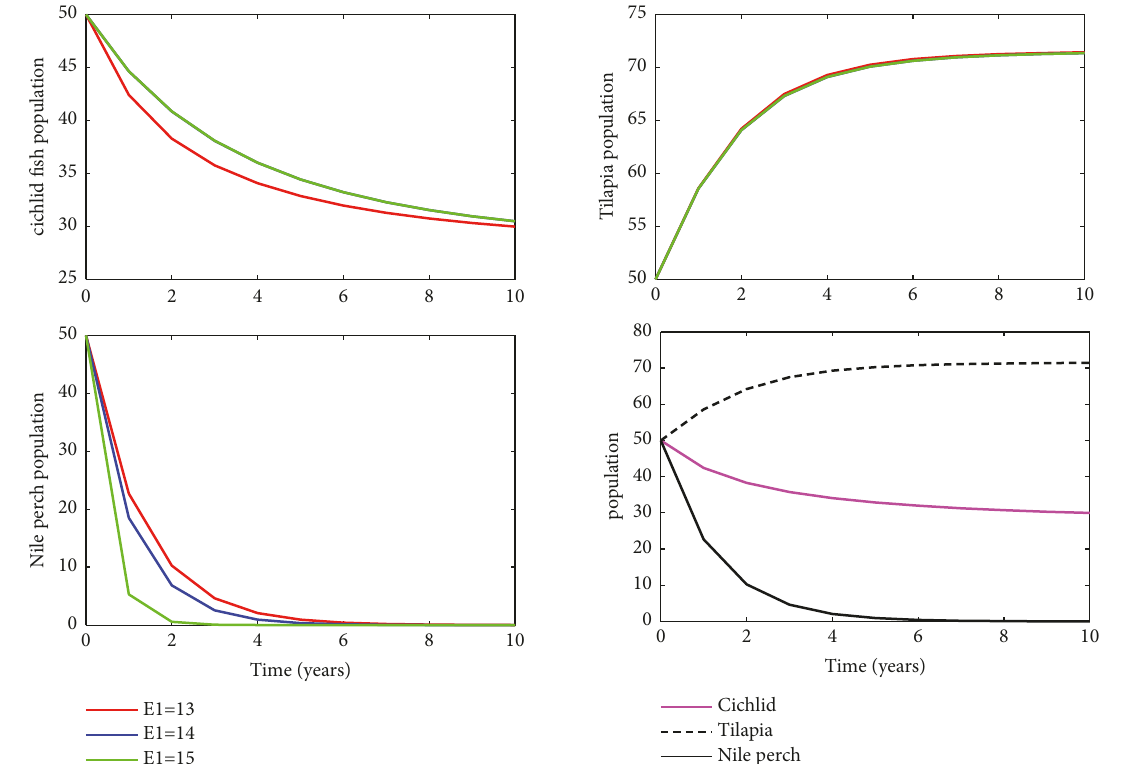
Figure 3: Variation of the fishes population with different harvesting efforts in cichlid 𝐸1 with fixed values of 𝐸2 and 𝐸3 .